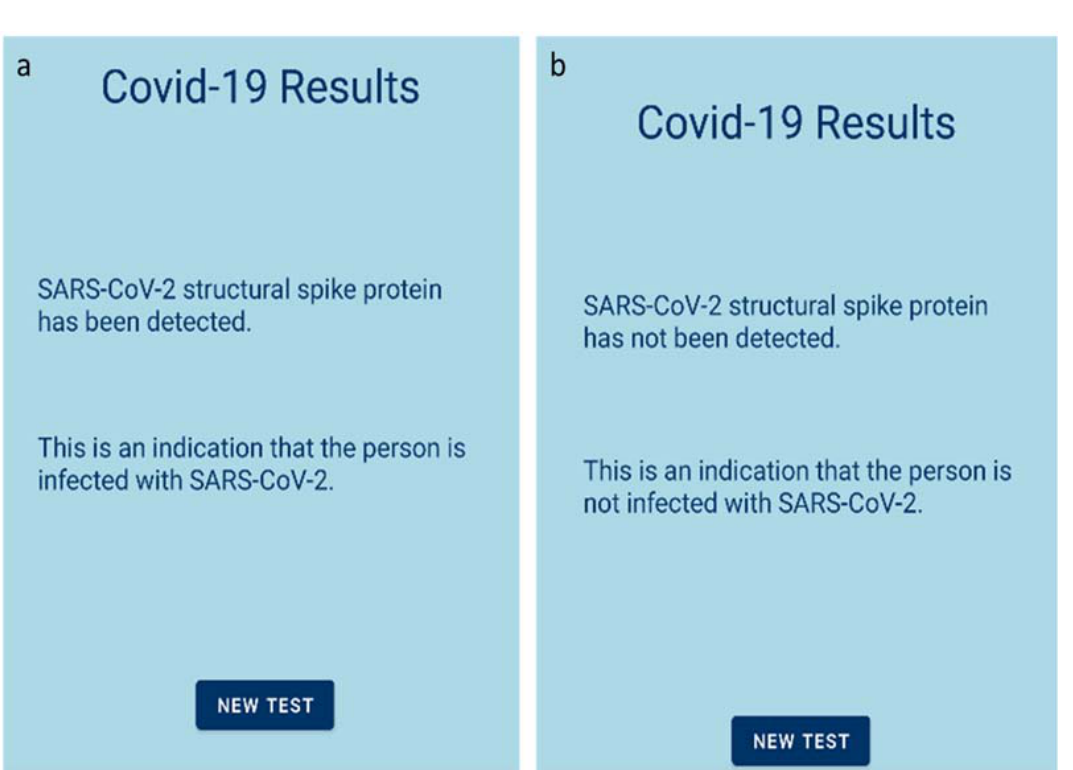
Figure 8. Mobile application results; ( a ) test positive for S protein; ( b ) test negative for S protein.